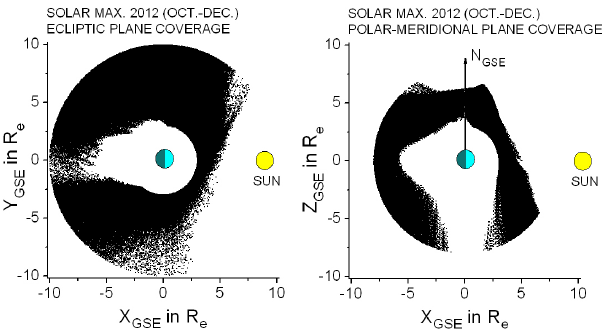
Figure 9. Observational LOS coverage of the solar maximum data set: LOS intersections with (left) the ecliptic plane (within an an- gular extent of θ ± 25 ◦ around the ecliptic plane) and (right) the polar-meridional plane (within an angular extent of φ ± 25 ◦ around the polar-meridional